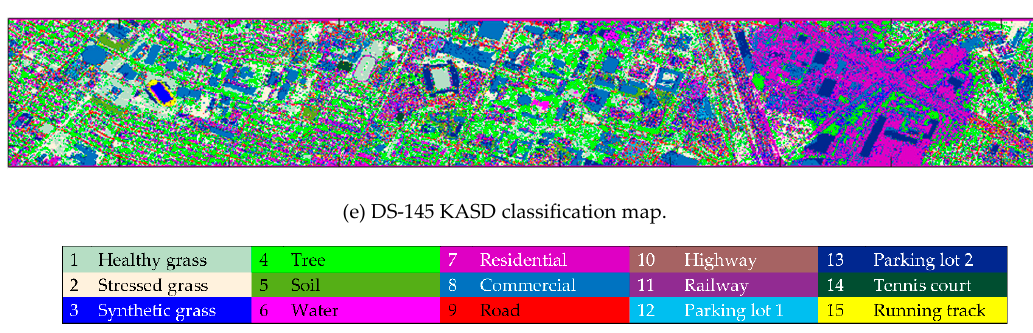
Figure A4. KASD classification maps.